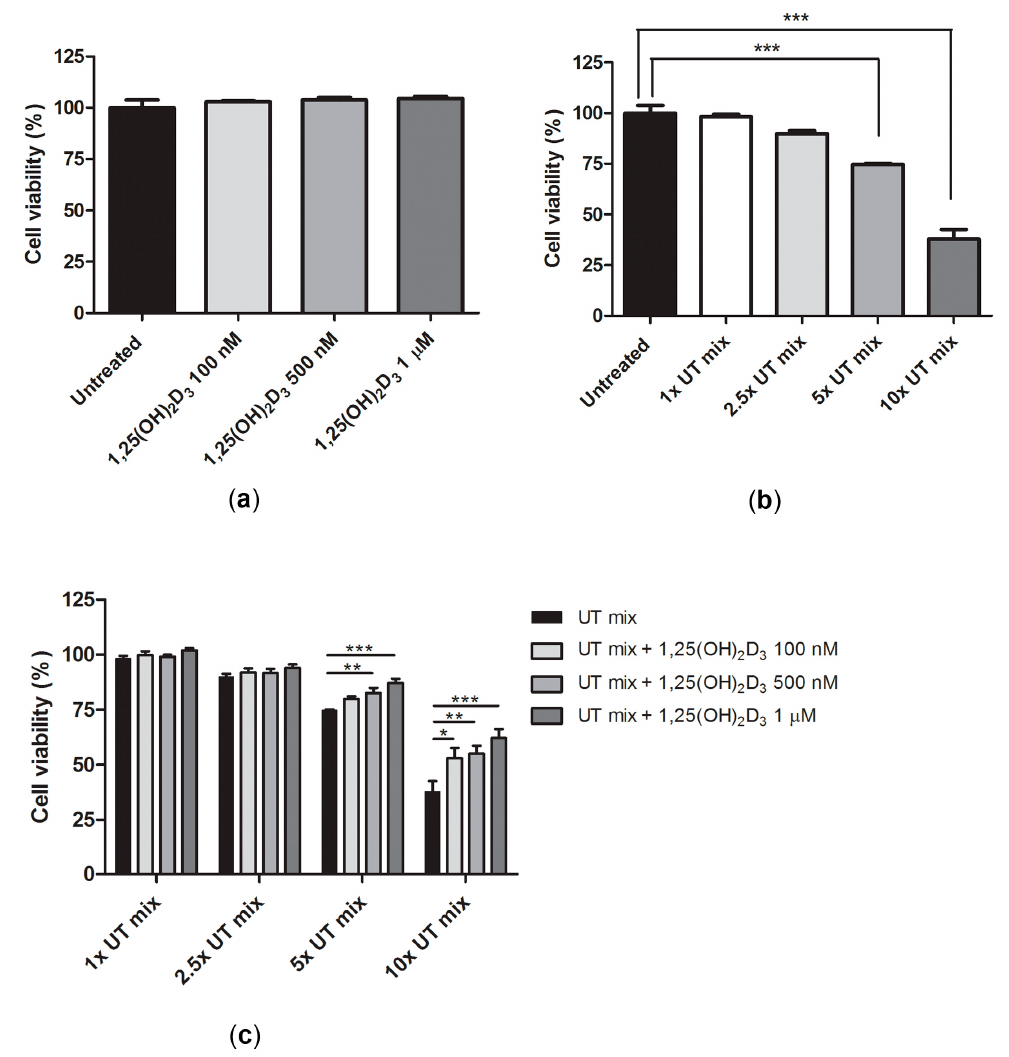
Figure 3. Effect of vitamin D on ciPTEC-OAT1 viability in uremic conditions. CiPTEC-OAT1 viability (relative to untreated cells) following 24 h exposure to ( a ) 1,25(OH) 2 D 3 alone (100 nM, 500 nM and 1 μ M), ( b ) increasing concentrations of UT mix (1×, 2.5×, 5×, and 10×), and ( c ) combination of 1